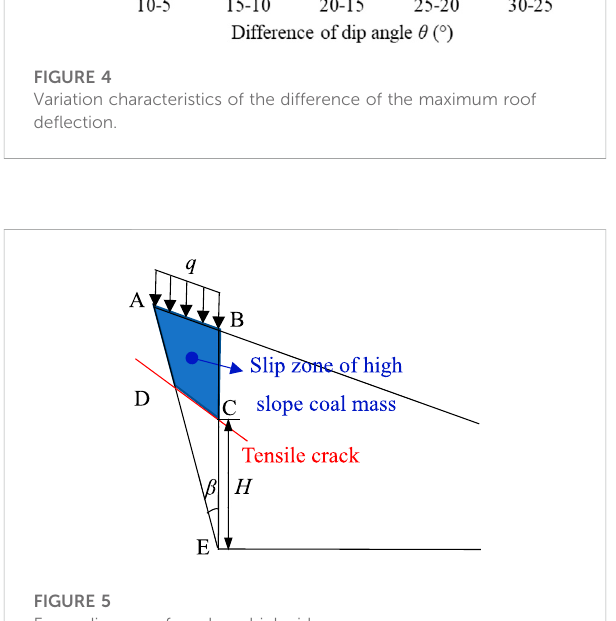
FIGURE 2 Roof force diagram.